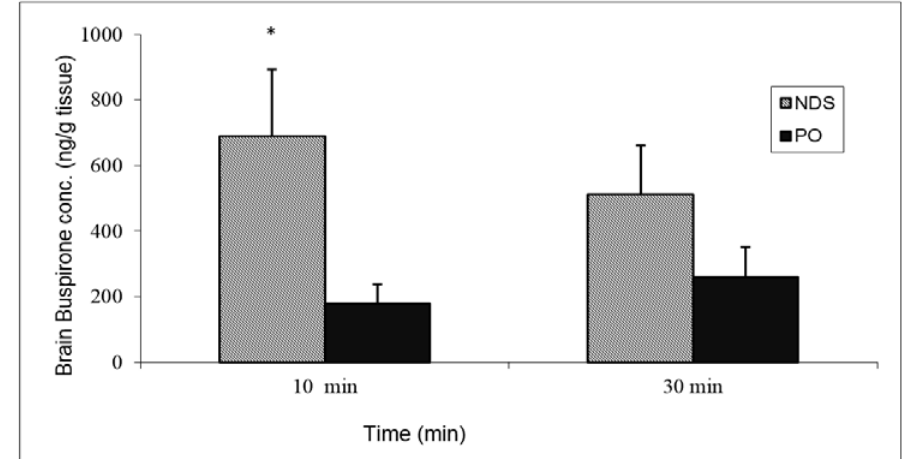
Figure 7. Brain buspirone concentrations after administration of buspirone NDS to rat at a dose of 3 mg/kg compared with oral administration (PO). Data represent the mean ± SD, n = 5 for each group. * p < 0.05 significant by unpaired two-tail t -test.